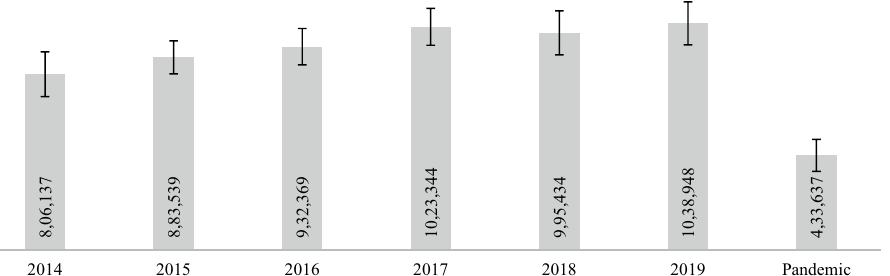
Figure 1. Average monthly consumption (± standard deviation) of antibiotics in Brazil, by children aged 1–12 years, during 2014–2019 and the pandemic period (Jan 2020–July 2021).